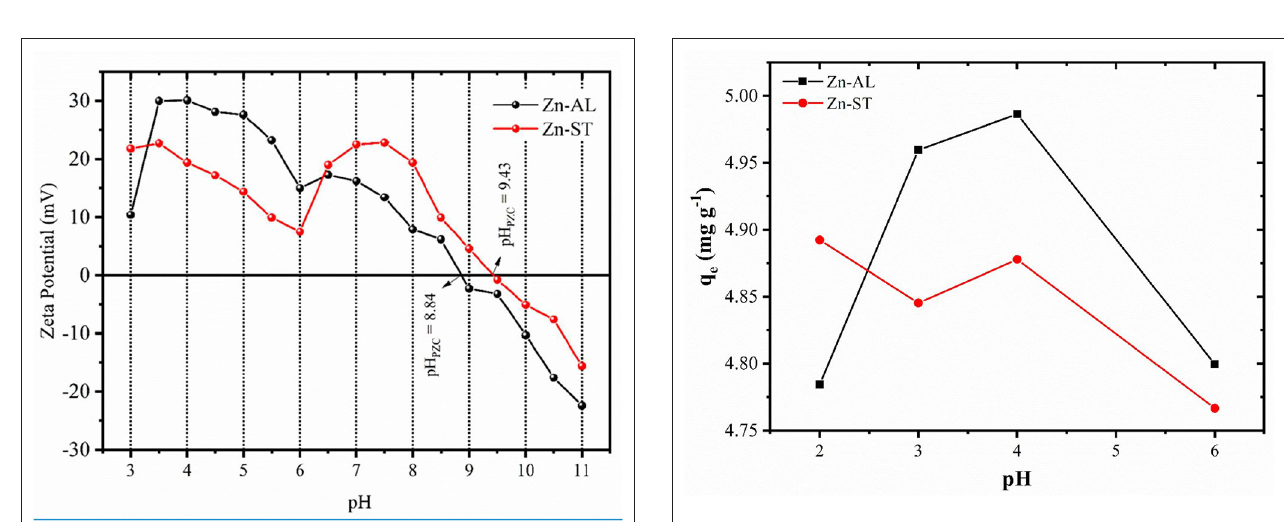
FIGURE 6 | Effect of the pH on the adsorption of the Cu (II) ions by the Zn-AL and Zn-ST oxides.